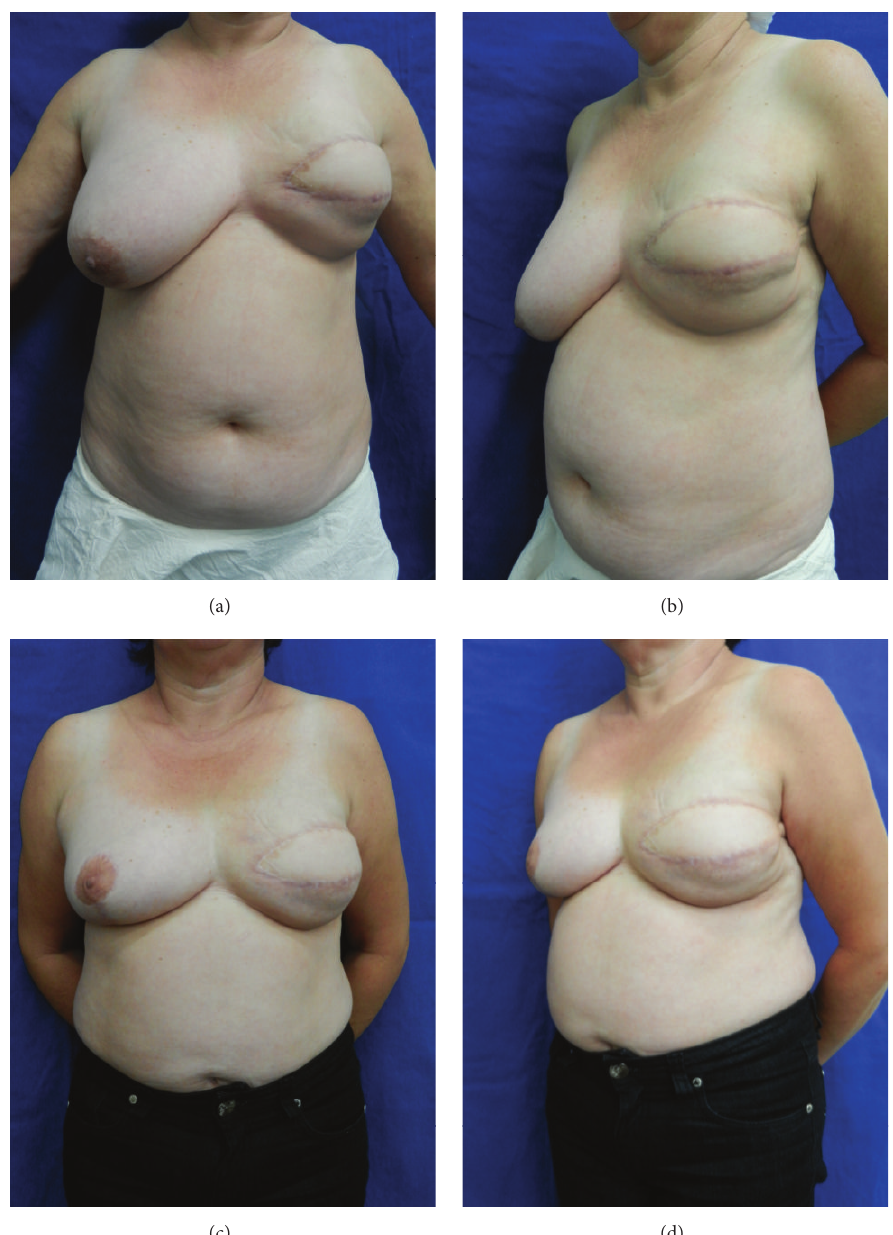
Figure 4: (a, b) Preoperative frontal and oblique views of a SG patient in which 141cc of enriched fat was injected; (c, d) 12-month postoperative frontal and oblique views with volumetric persistency of